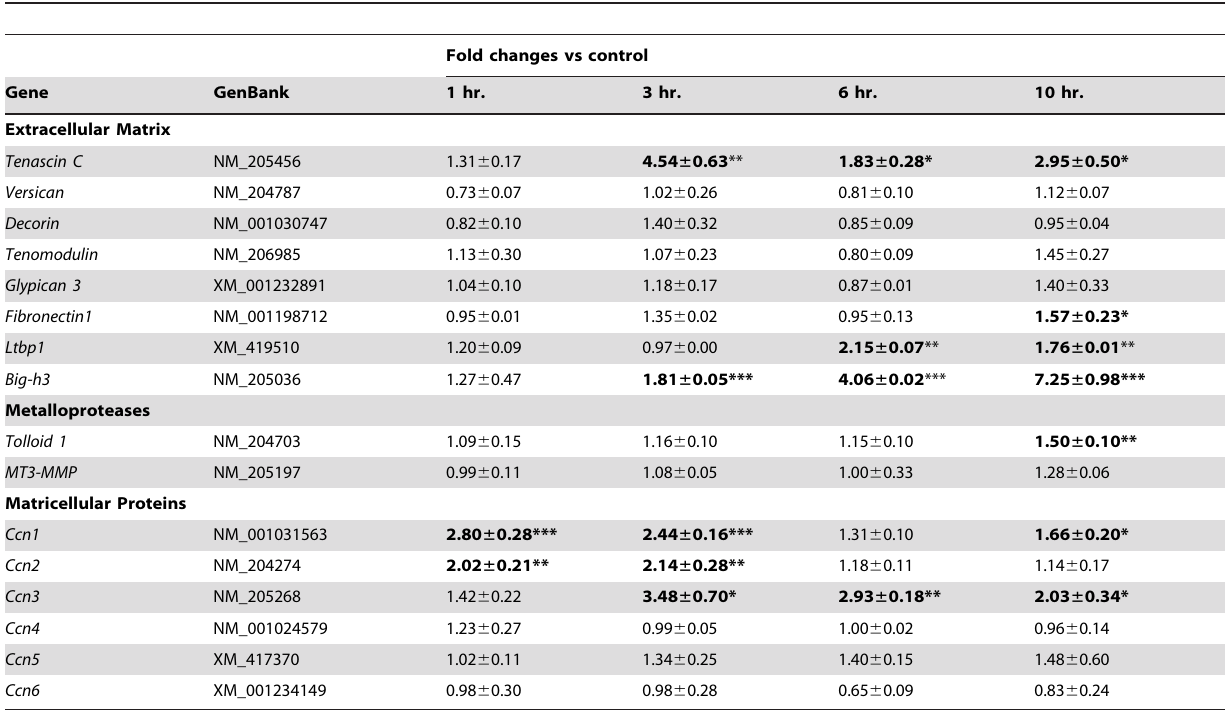
Table 3. Regulation of extracellular matrix genes at 1, 3, 6, and 10 hr after interdigital implantation of beads bearing Tgf- b 1.